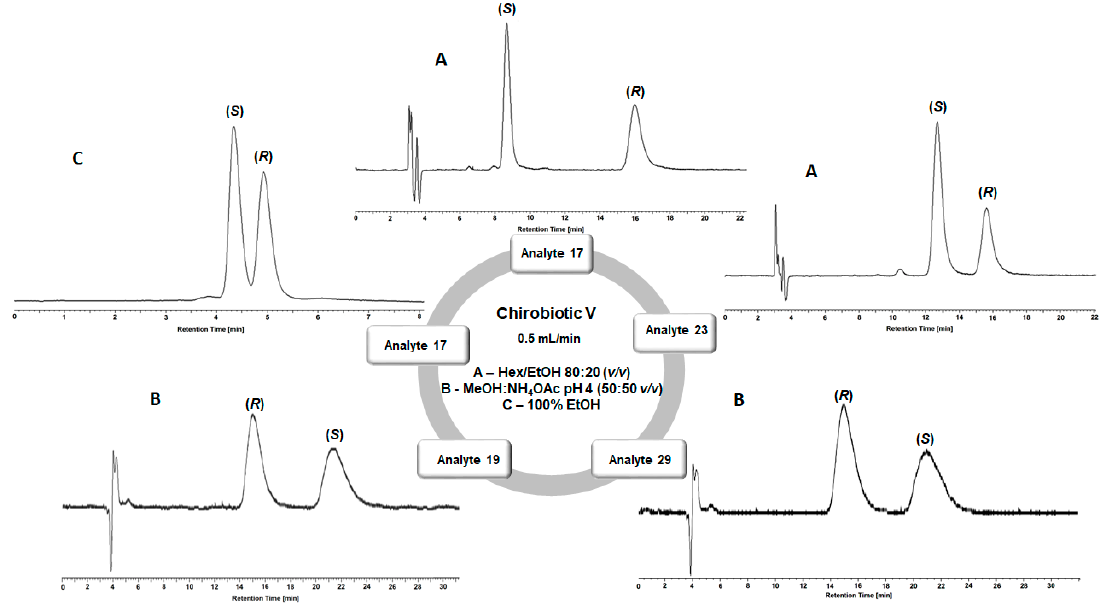
Figure 5. Chromatograms of xanthonic analytes 17 , 19 , 23 and 29 on the Chirobiotic TM V column.